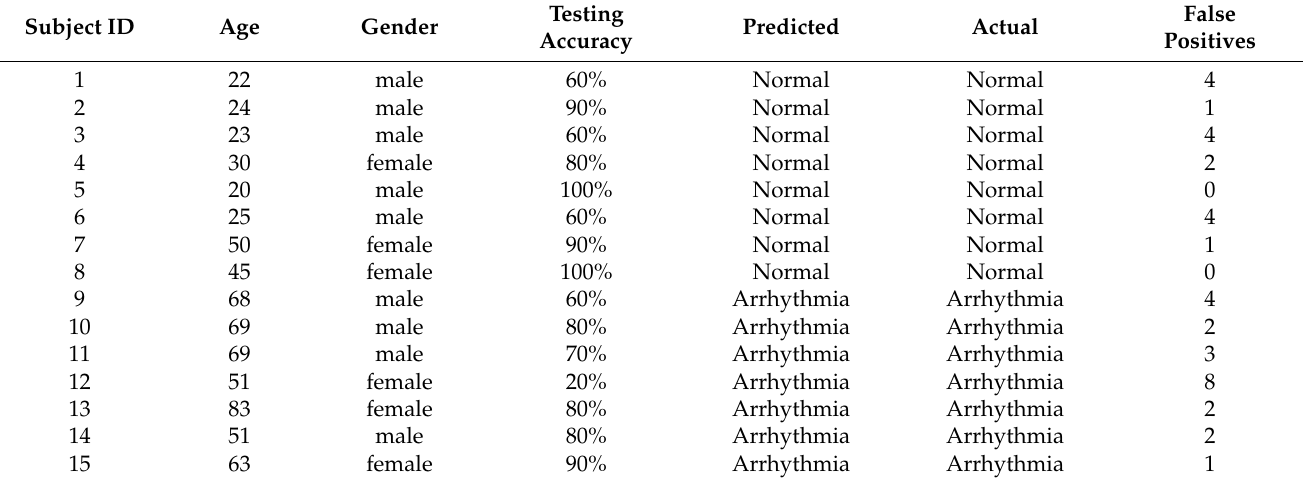
Table 9. Testing accuracies of 15 subjects: the average test accuracy was estimated to be 75% for 15 subjects. The coefficient of determination of 0.876 for the trained dataset is